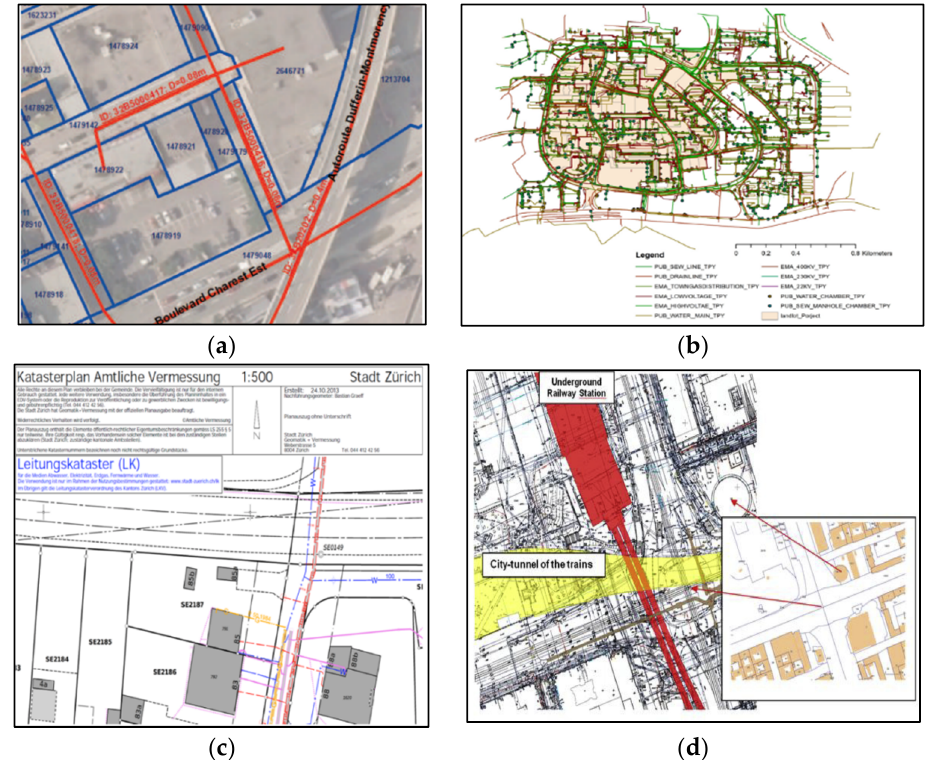
Figure 6. Some works on registering underground assets: ( a ) underground communication cables and 2D land parcels, Canada [10]; ( b ) utility networks and 2D land parcels, Singapore [62]; ( c ) utility cadastre, Switzerland [61]; and ( d ) subway data on a cadastral and base map, Poland, adapted with permission from ref. [63],